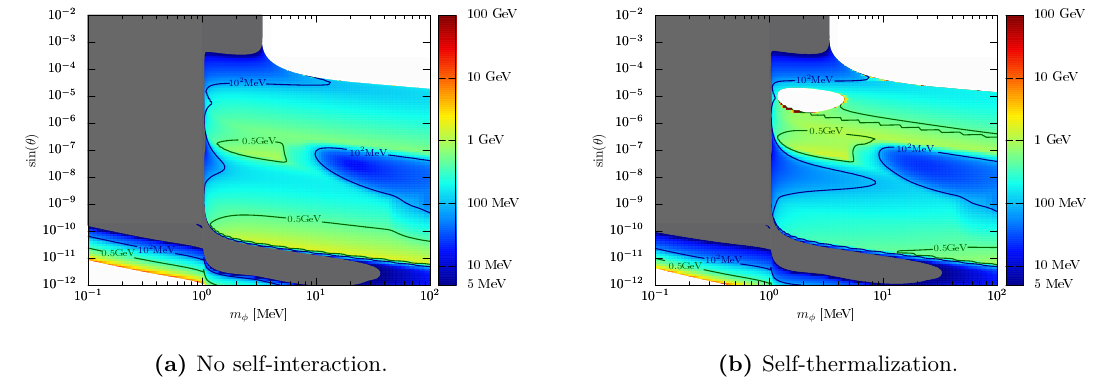
(b) Self-thermalization. Figure 18. The upper-bound on the reheating temperature from the cosmological constraints. The gray regions are excluded for an arbitrary reheating temperature. The white regions, on the other hand, are compatible with the cosmological constraints for an arbitrarily high reheating temperature.